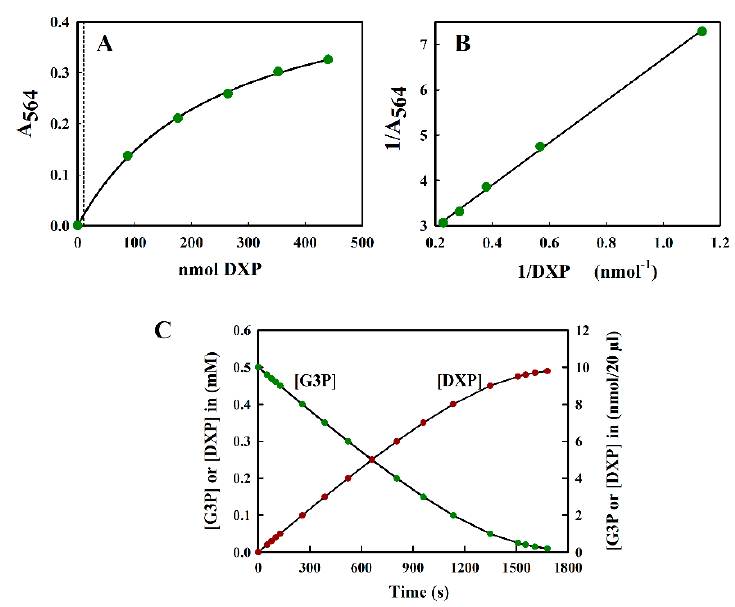
Figure 5. ( A ) The standard curve of DXP measured at 564 nm. All measurements were performed in triplicate, and the average value is indicated. The curve could be fitted to the hyperbolic equation y = ax/(b + x), where the fitted constants were: a = 0.507 ± 0.0124 and b = 244.323 ± 12.946. The dotted line indicates the upper limit (10 nmol) of the region relevant for the DXS assay shown in ( C ). ( B ) The inverse plot of the data shown in ( A ). ( C ) The theoretical progress curve of the DXS reaction, with pyruvate and G3P as substrates. The pyruvate concentration was assumed to be kept at a saturating level, whilst the G3P concentration steadily decreases as DXP is formed.